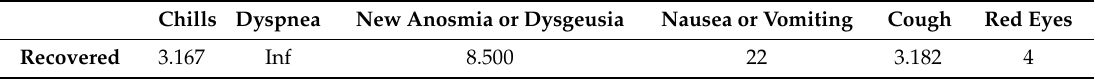
Table 8. Relative risk of recovered